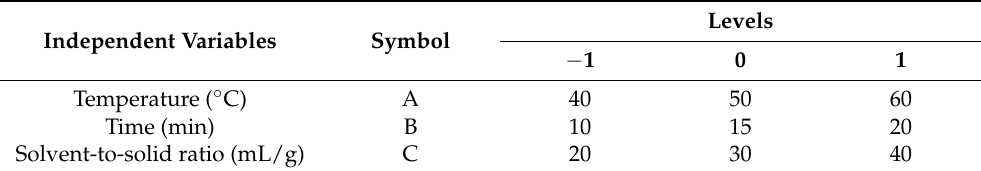
Table 2. Variables and factor levels for optimization of extraction.